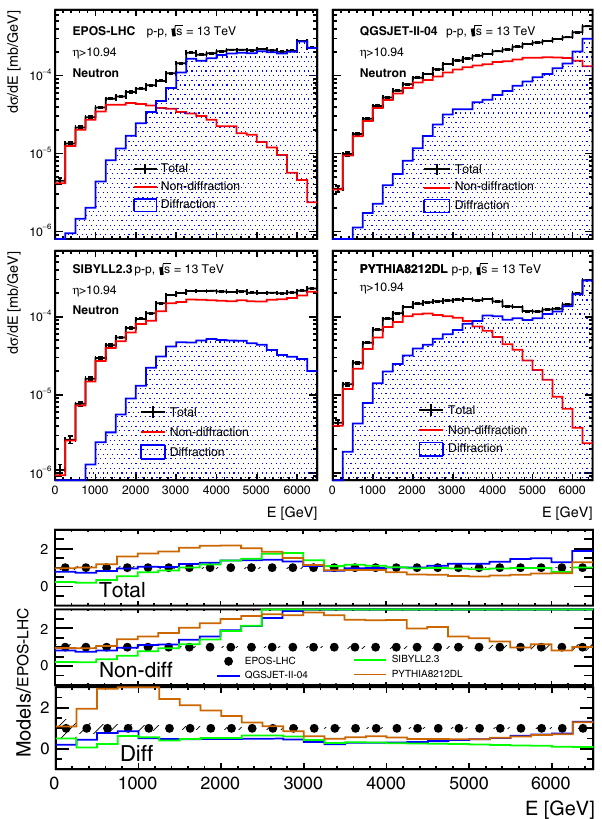
tom three plots show the ratios of the spectrum of EPOS-LHC ( black markers ), QGSJET-II-04 ( blue lines ), SYBILL 2.3 ( green lines ), and PYTHIA8212DL ( orange lines ) to the spectrum of EPOS-LHC. The top , middle , and bottom plots correspond to total, nondiffraction, and diffraction,